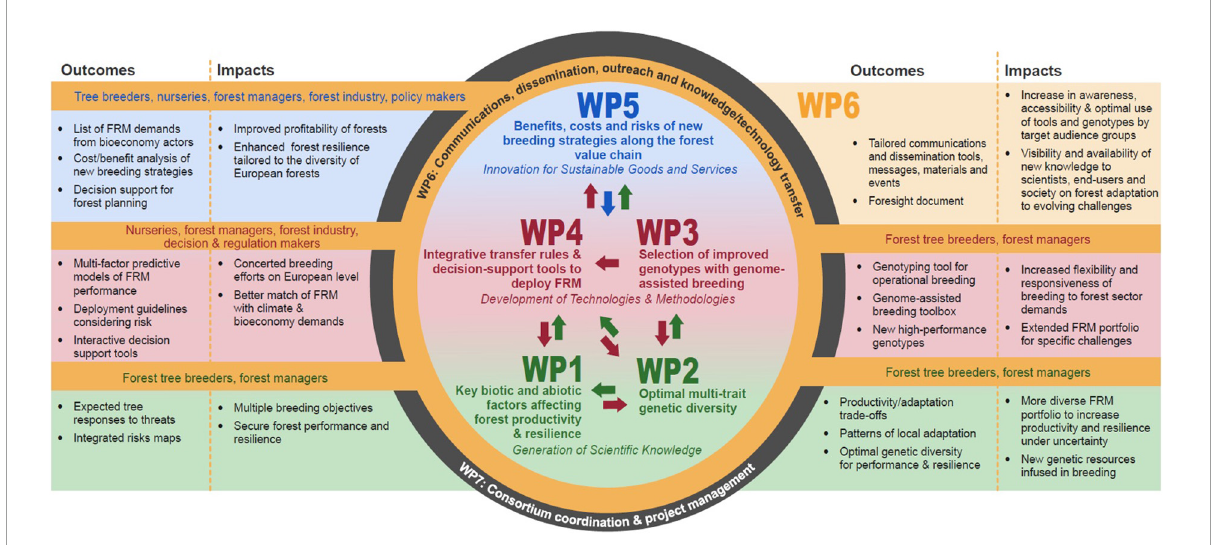
FIGURE1 Science area interactions, outcomes, audiences, and impacts of